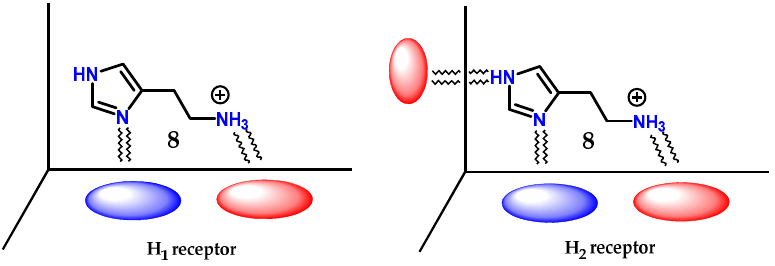
Figure 39. Scheme of the spatial arrangement for the interaction of histamine 8 on the H 1 and H 2 receptors.